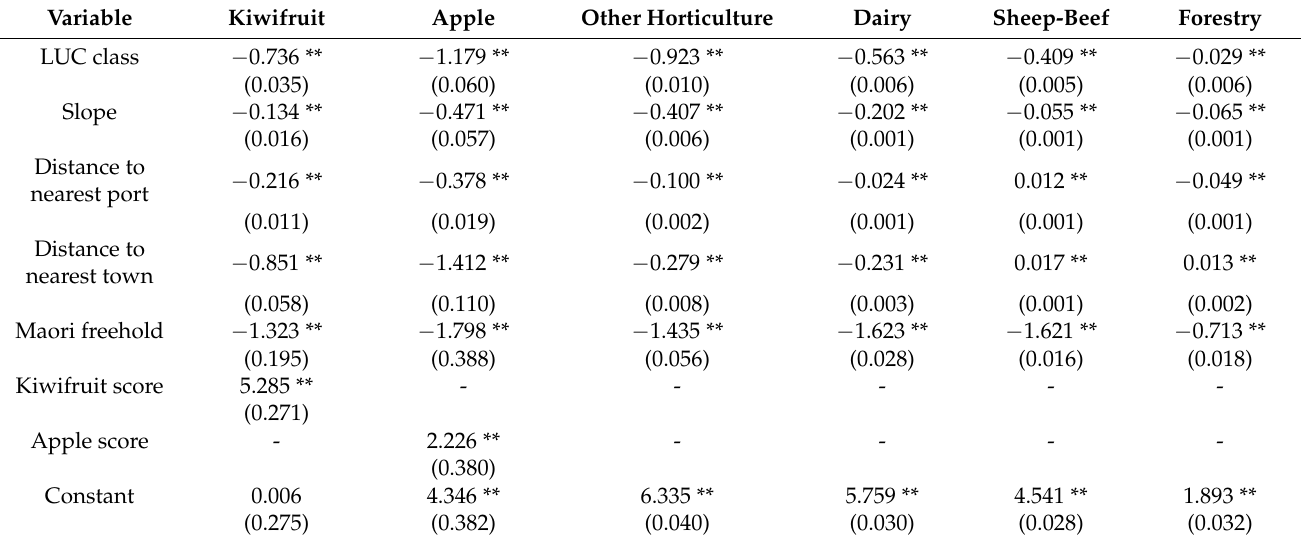
Table 5. Multinomial logit estimation results. Standard errors are shown in parentheses. Asterisks indicate statistical significance at the 1% (**) and at the 5% (*)